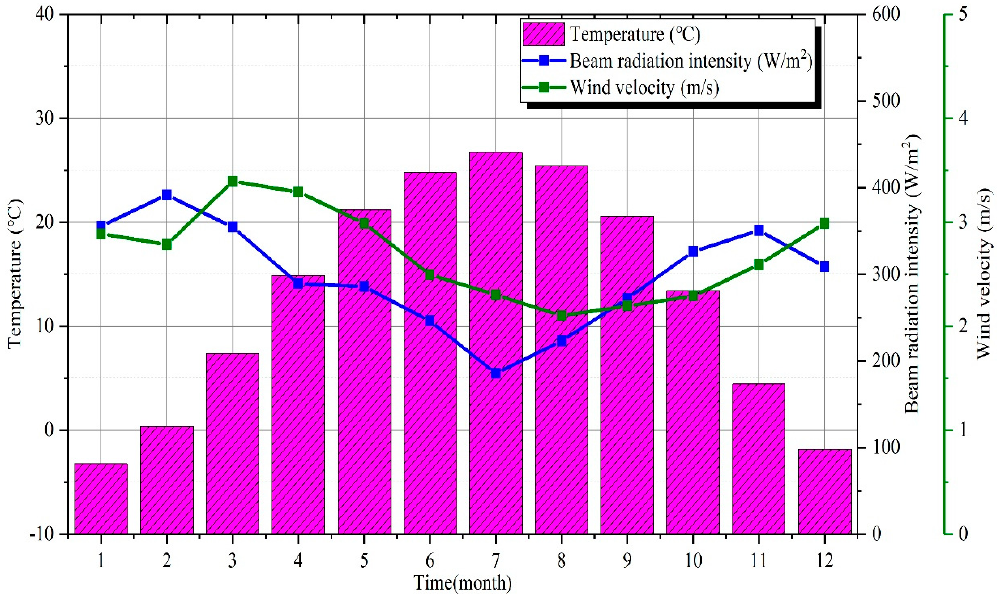
Figure 4. The curve of meteorological parameters throughout one year.